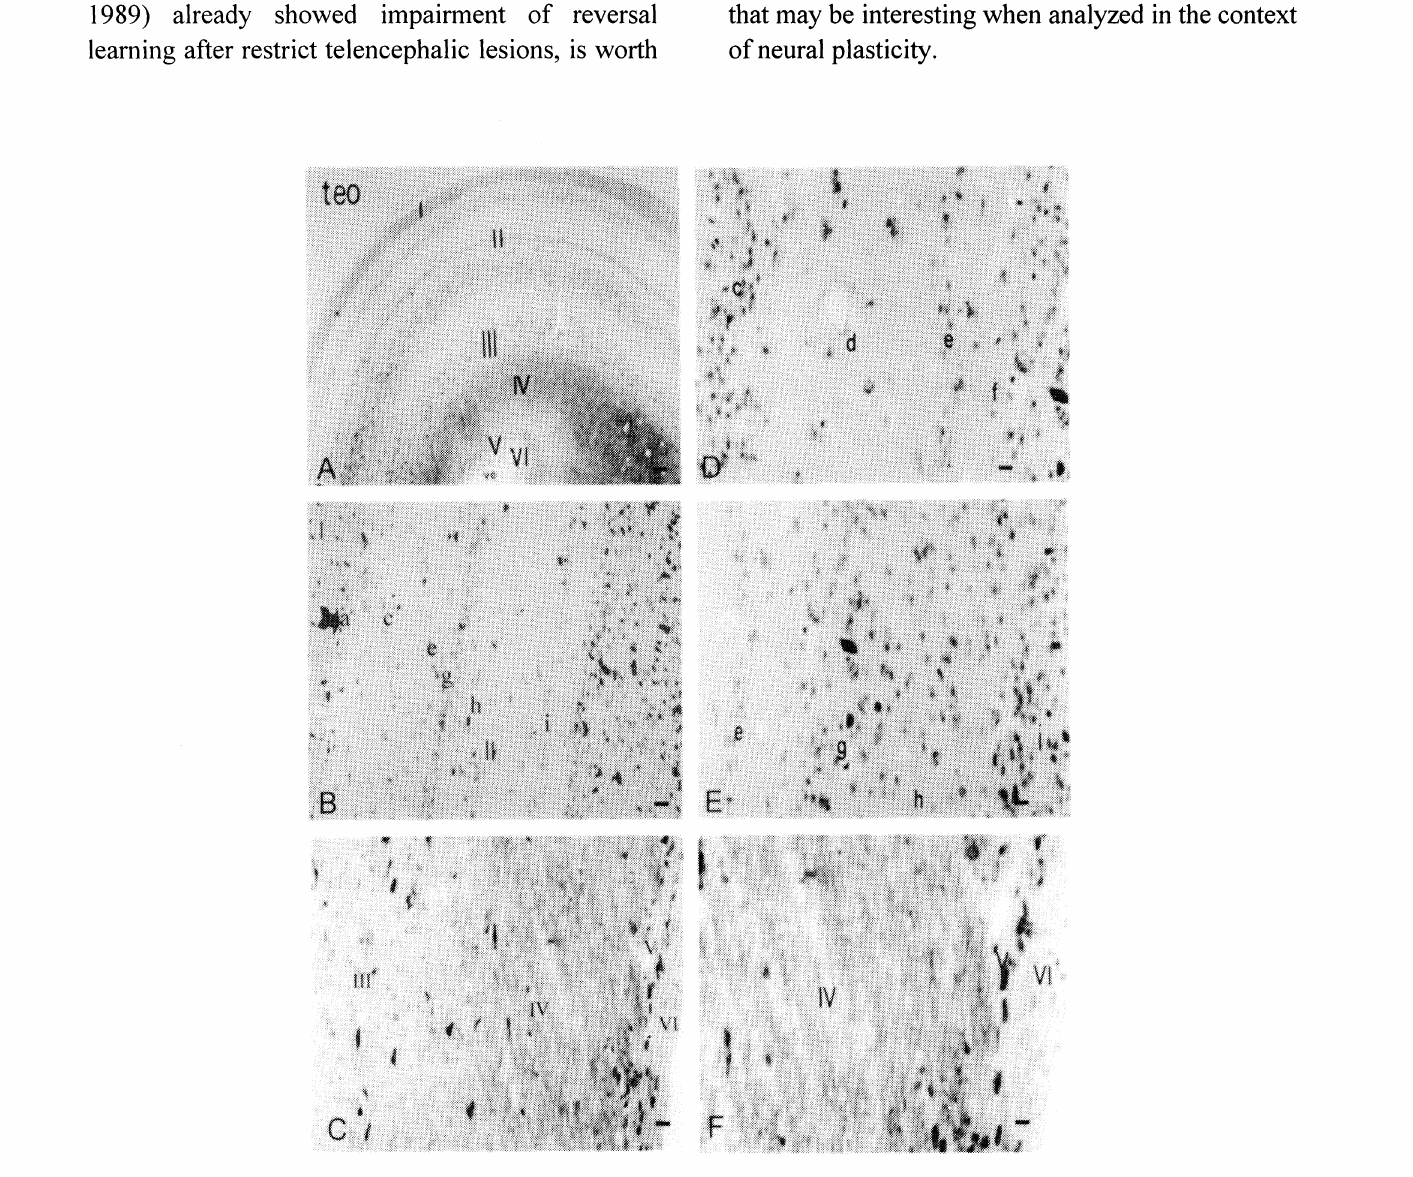
Fig. 8: Microphotographs showing OT in frontal section (10gm) in the brain of one non lesioned pigeon (Control). Cell bodies and myelinated fibers were visualized using Kltver-Barrera technique. The animals were sacrificed 120 days after surgery. Layer I- IV (A-C) layer II (a-j) (D-E) and layer lI(g-I) and layer Ill (F). A 10 gm; B 20 gin; C 40gm; D, E,